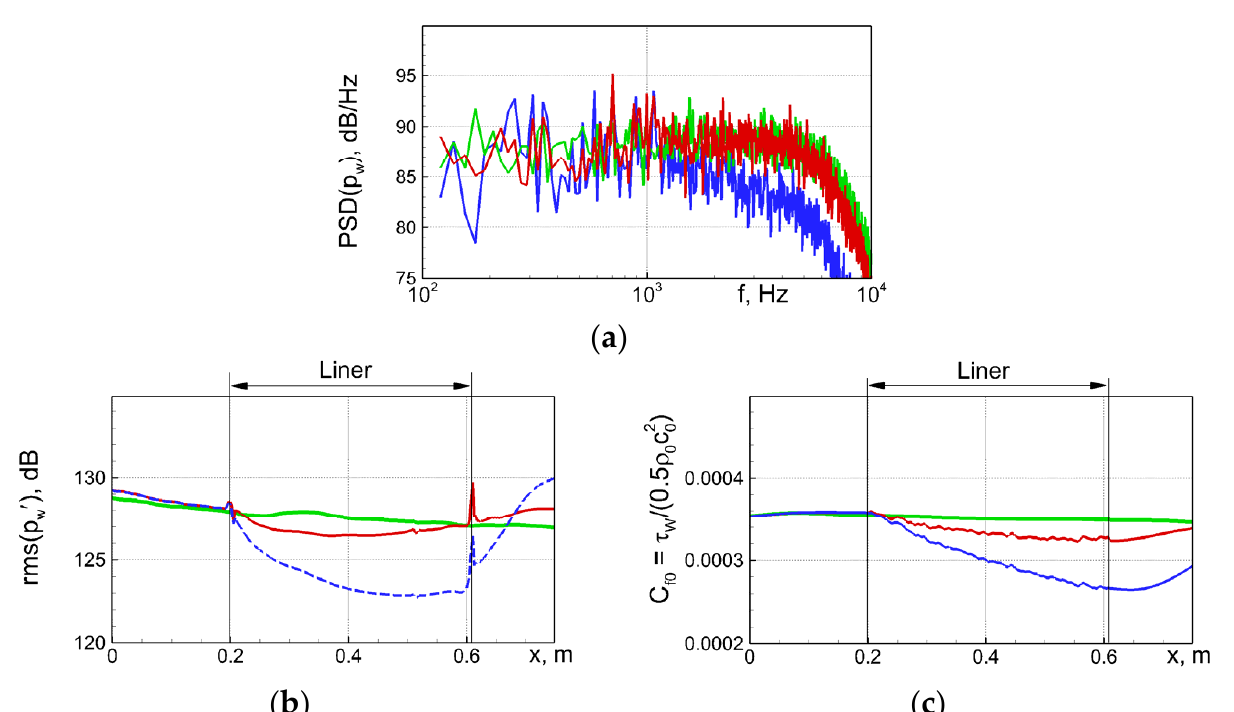
Figure 14. Same as in Figure 13, for wall-pressure spectra at x = 0.6 m ( a ) and streamwise distributions of root-mean-square wall-pressure pulsations ( b ) and mean friction coefficient ( c